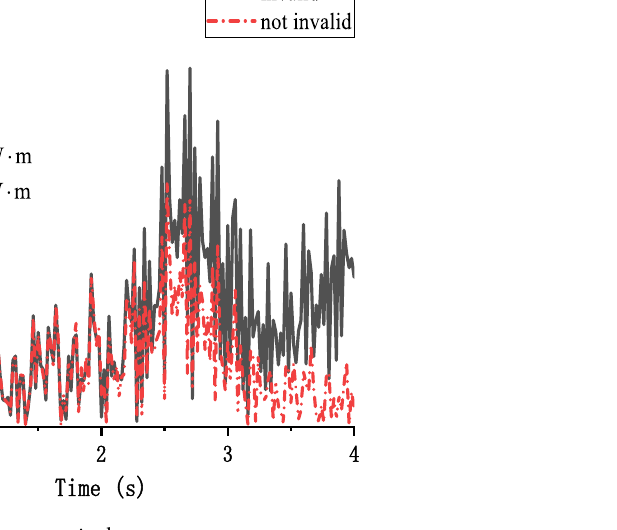
Figure 14. Bending moment at pier